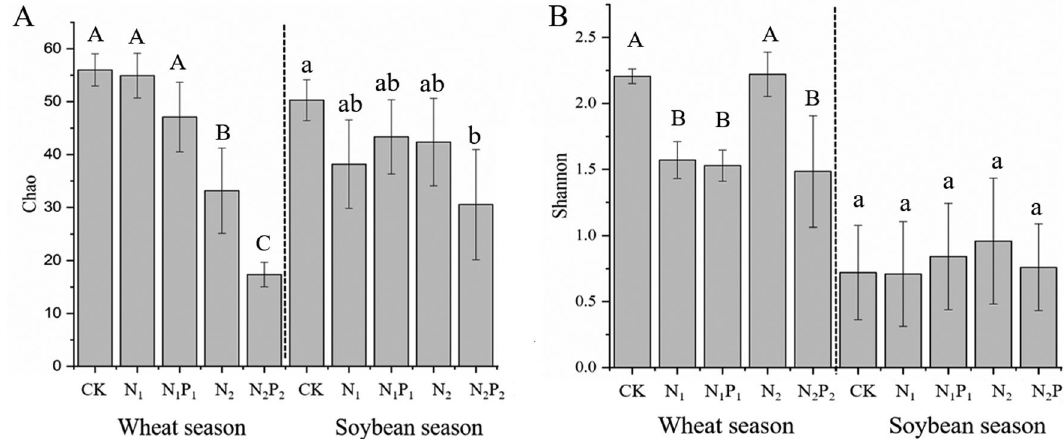
Figure 2. α diversity indices of nitrogen-fixing microorganisms in soil samples under different fertilizer treatments. ( A ) Chao index, ( B ) Shannon index.